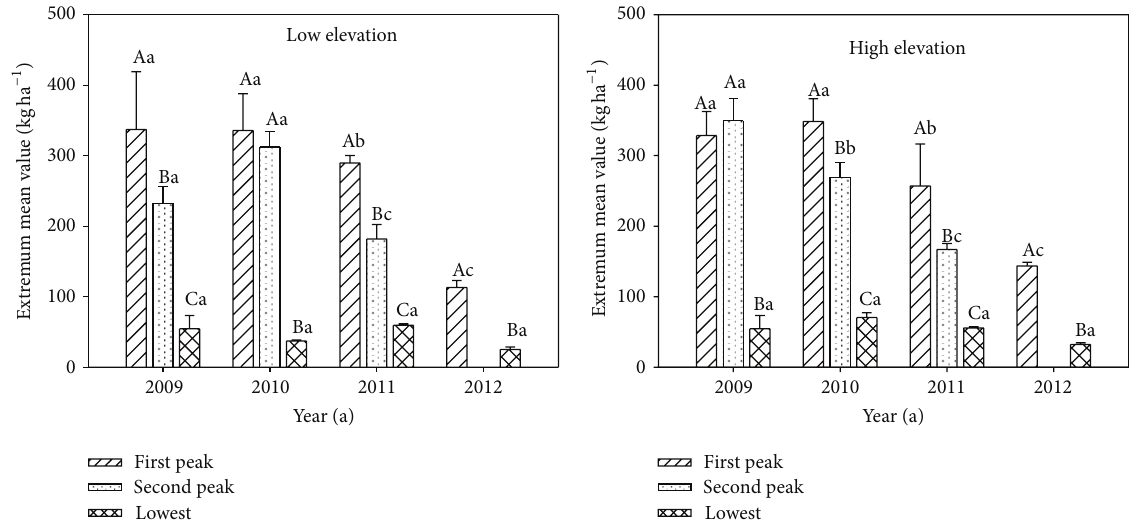
Figure 4: The peak and valley value of litterfall at two elevations in 2009.01–2012.12. Different capital letters in the same group meant significant difference at 0.05 levels in the same year at each elevation; the different lowercase letters among the same indicator in four years meant significant difference at each elevation.